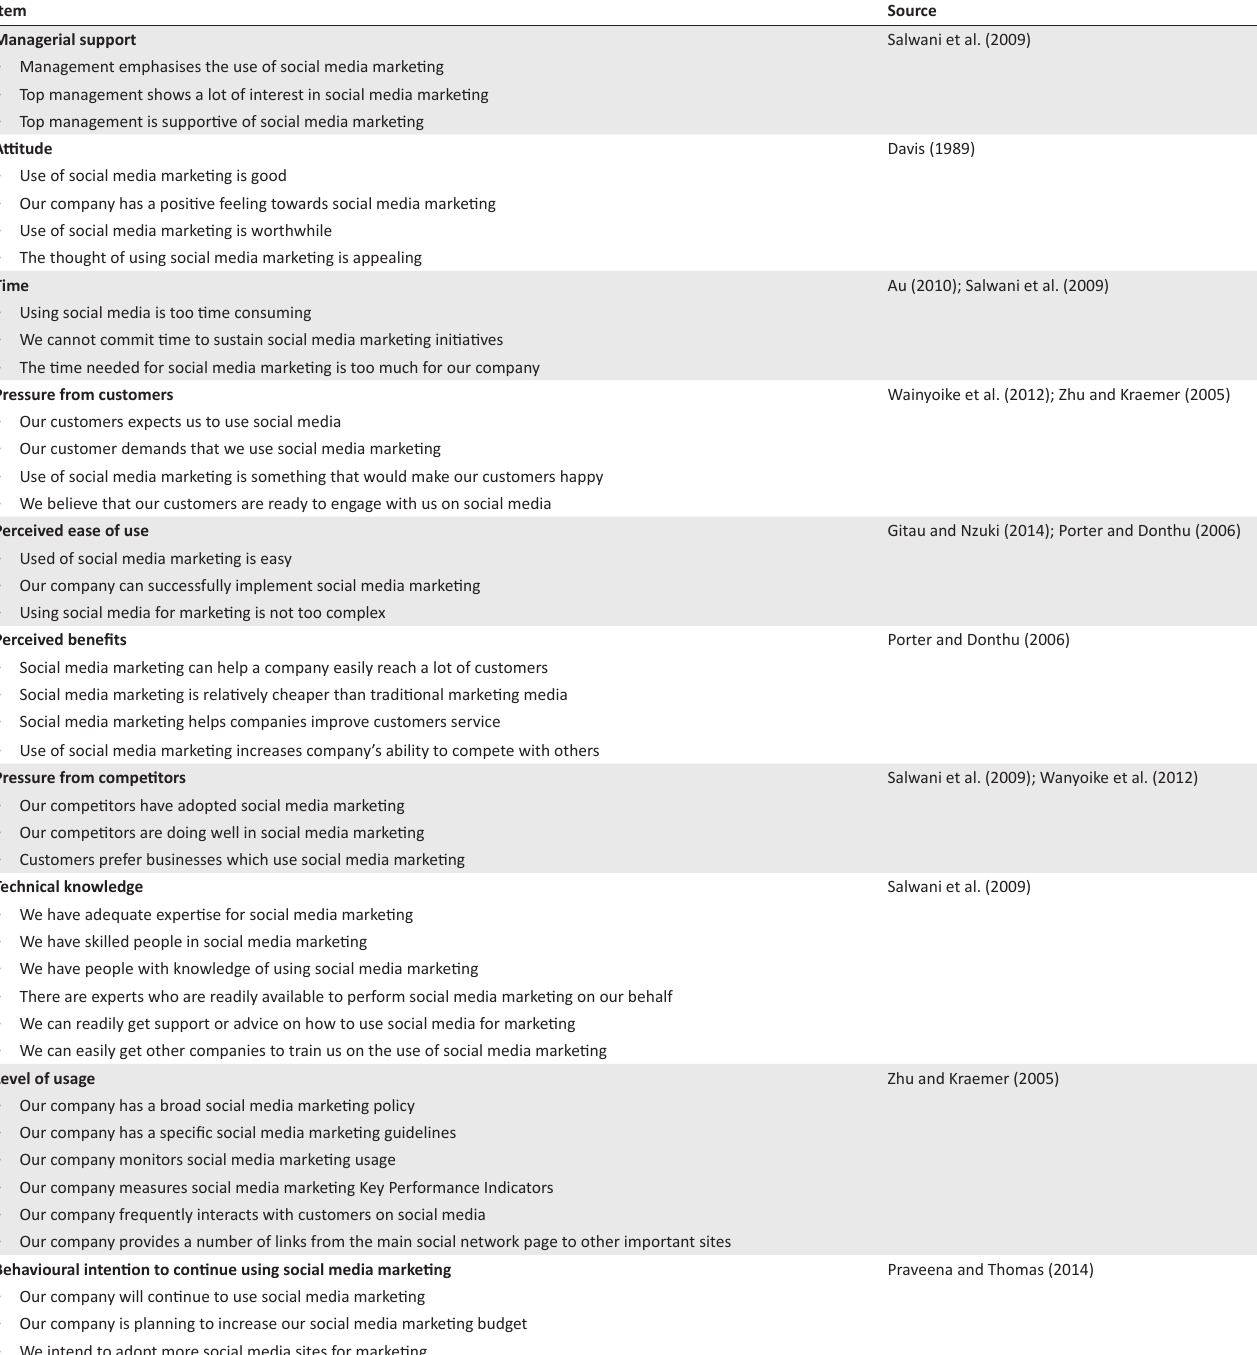
TABLE 1-A1: Questionnaire